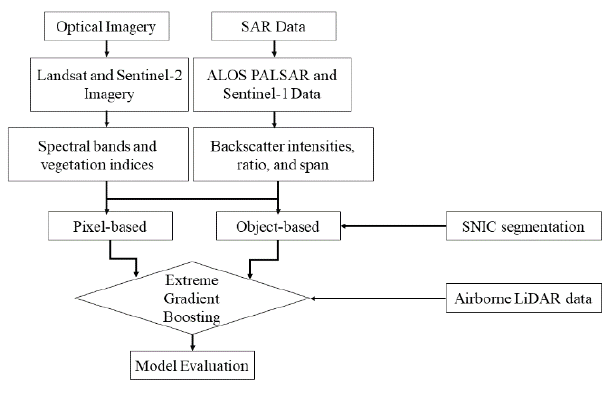
Figure 2 . An overview of the methodology used in the study for AGB